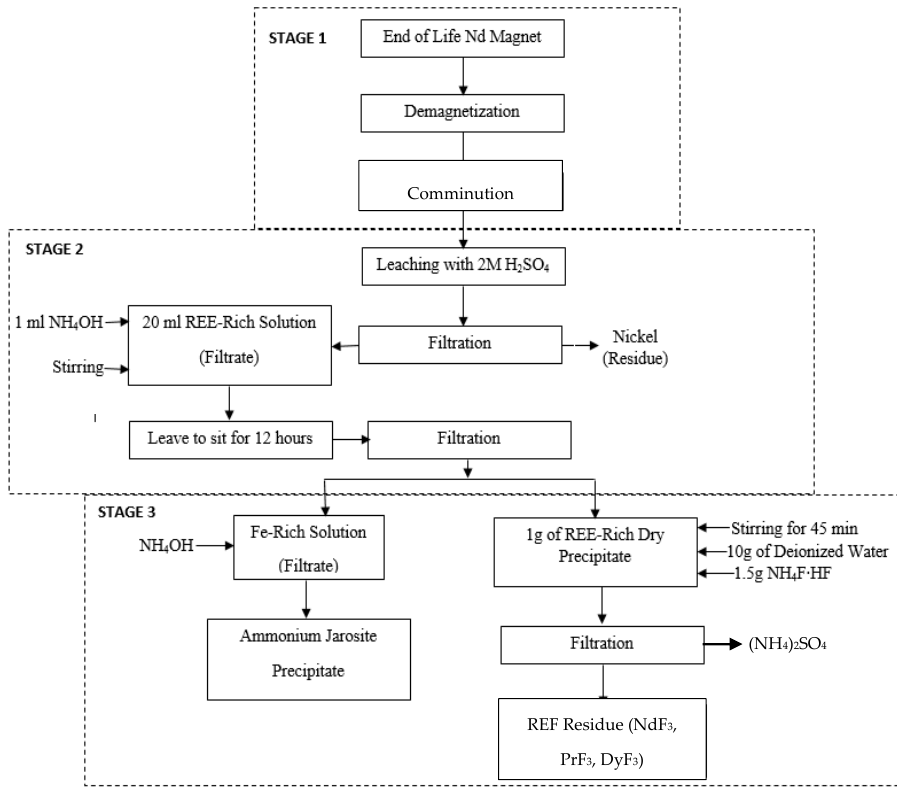
Figure 1. Flow sheet of Nd magnet recycling to produce REF.